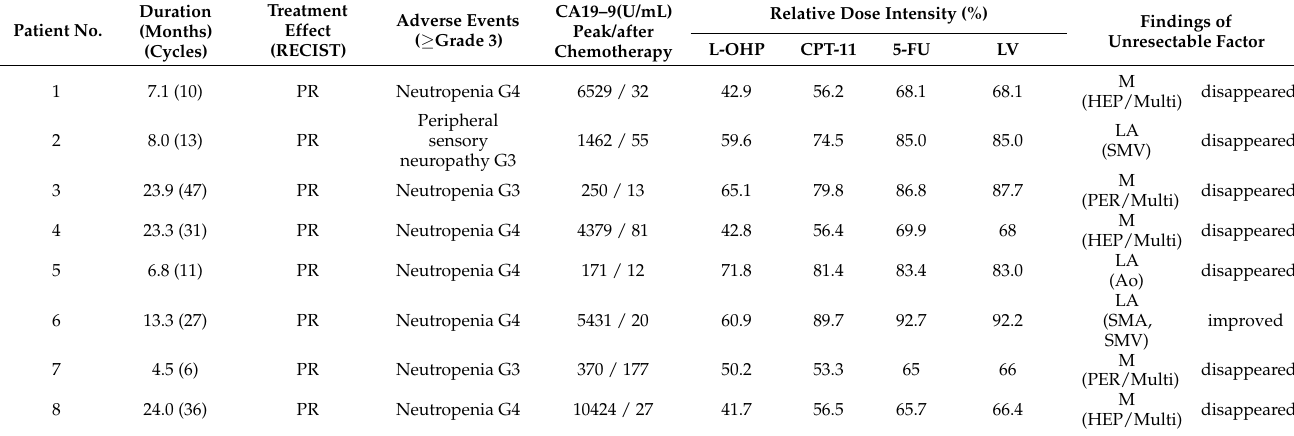
Table 3. Details and effects of preoperative